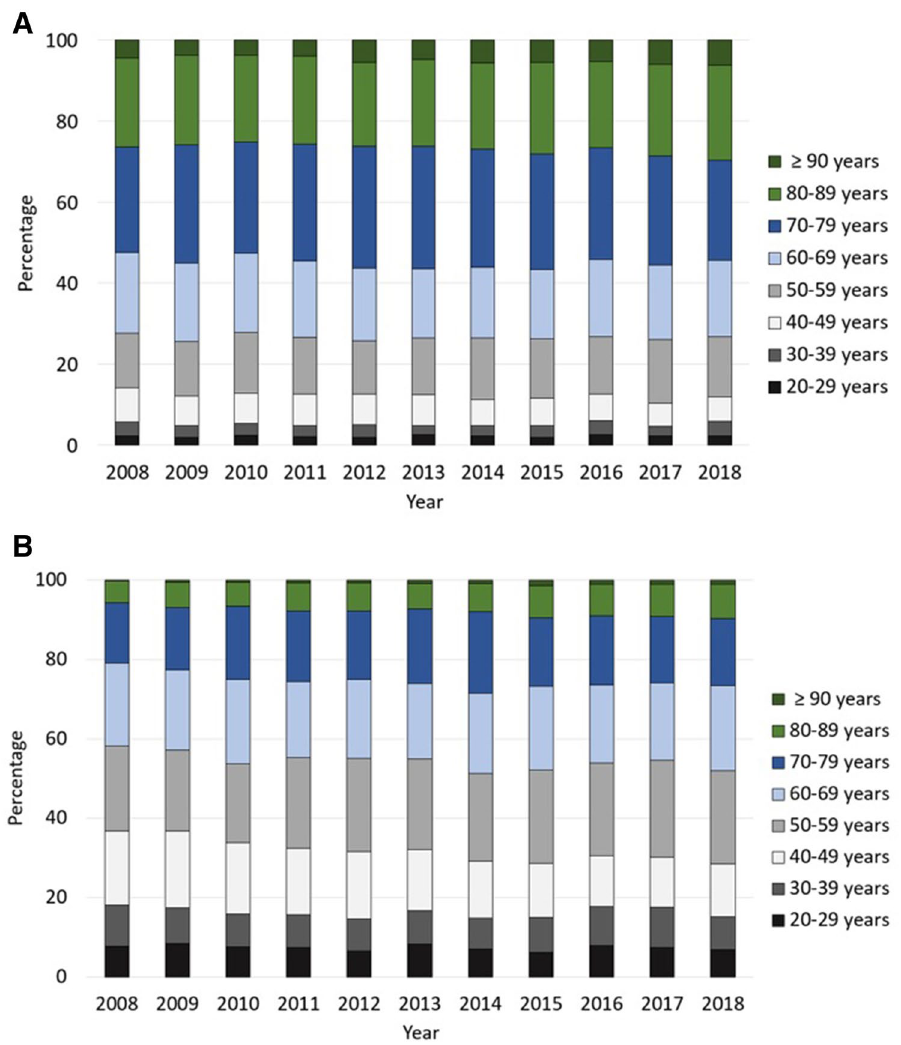
Figure 3. ( A ) Development of the internal proportion of male FRI cases divided by age group. ( B ) Development of the internal proportion of female FRI cases divided by age